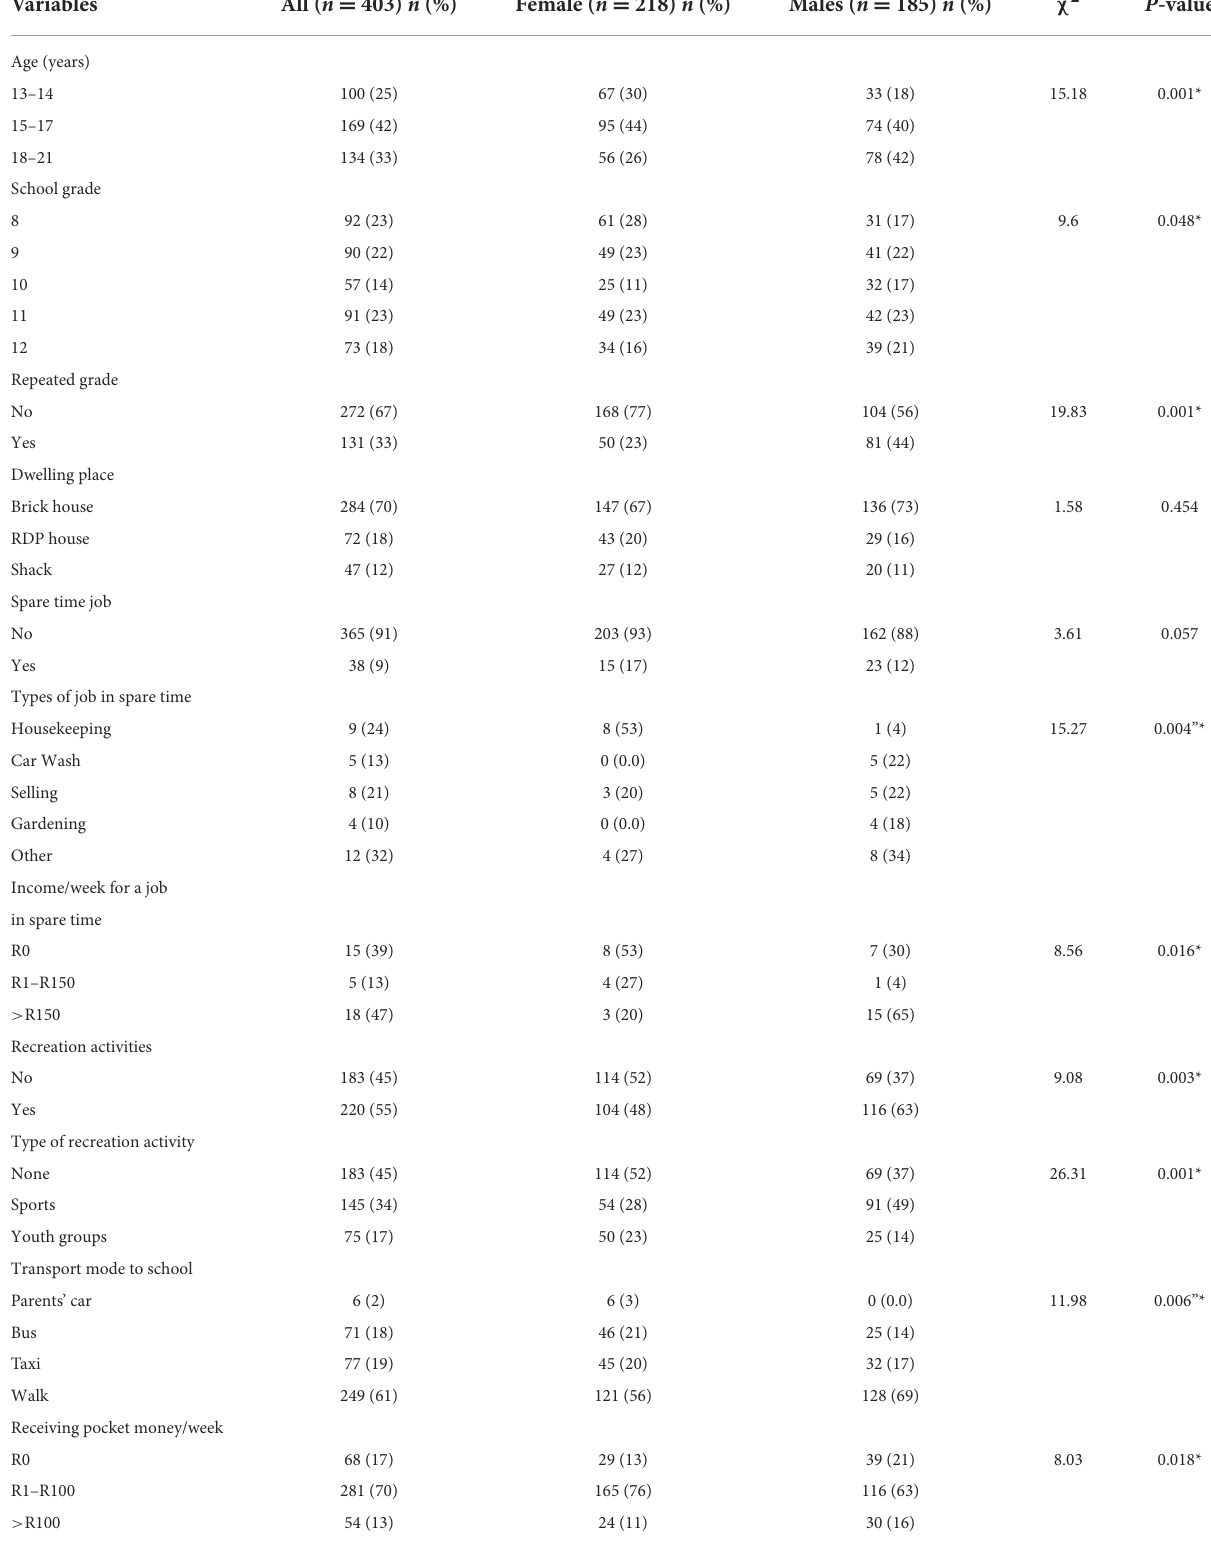
TABLE 1 Comparison of demographics of the adolescents by